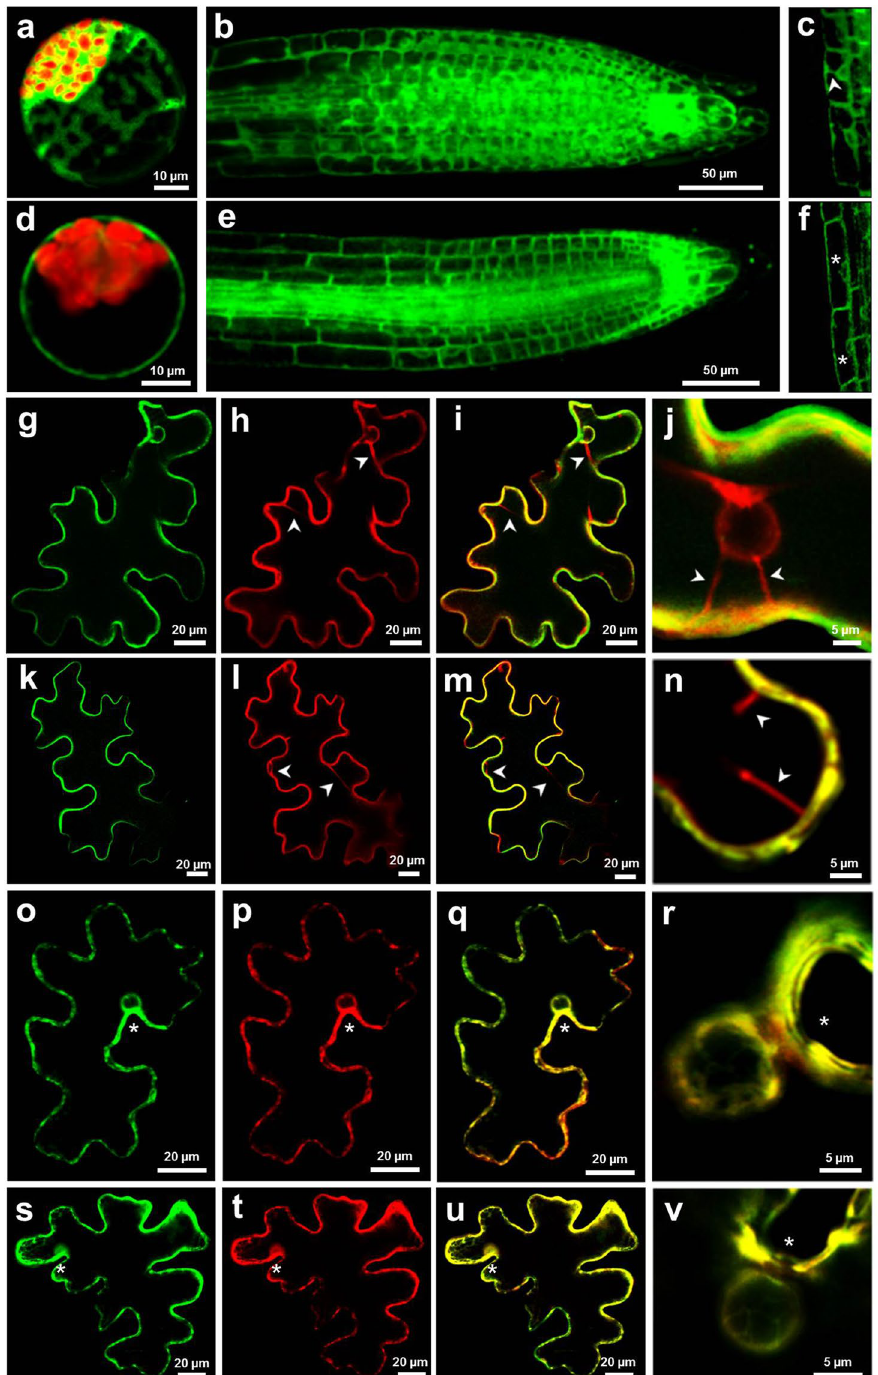
Figure 2. Subcellular localisation of the yeast Tpo1p and Pdr5p transporters in plant cells. ( a – f ) Confocal laser scanning microscopy images of Arabidopsis mesophyll protoplasts ( a , d ) or transgenic root tips ( b , c , e , f ), transiently or stably expressing either YFP alone ( a , b , c ) or the ScTPO1-YFP fusion ( d , e , f ), respectively, under the control of the 35S promoter. Root epidermal cell close-ups ( c , f ) are shown. The YFP and chloroplast autofluorescence signals are visualized by green and red coloration, respectively. ( g–v ) Confocal laser scanning microscopy images of individual tobacco leaf epidermal cells transiently expressing the ScTPO1- GFP ( g , i , j , o , q , r ) or ScPDR5-GFP ( k , m , n , s , u , v ) fusions and/or the tonoplast marker &#x0194;-TIPmCherry ( h , i , j , l , m , n ) or the plasma-membrane marker PIP2A-mCherry ( p , q , r , t , u , v ) under the control of the 35S promoter. Merged images of whole-cell views ( i , m , q , u ) or nucleus close-ups ( j , n , r , v ) are shown. Arrowheads point to transvacuolar strands, and asterisks indicate fluorescence signals approaching the nucleus only on the side facing the exterior of the cell ( o – v ) or surrounding the nucleus ( f ). The GFP and mCherry signals are visualized by green and red coloration,